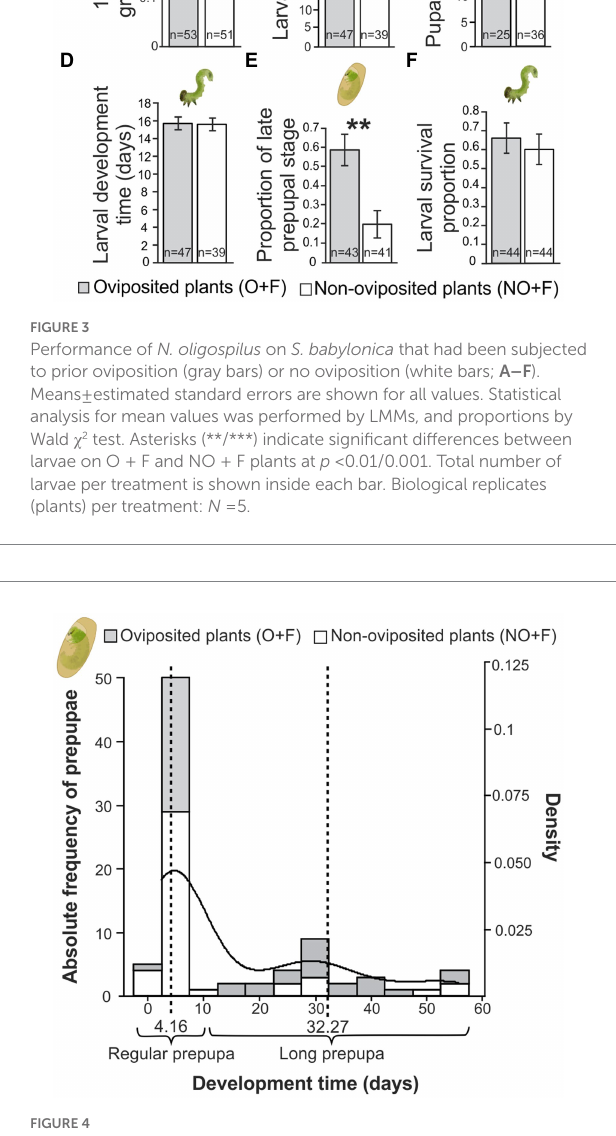
FIGURE 4 Histogram and density plot of distribution of prepupal developmental time. Absolute frequency of prepupae that developed from willows with prior oviposition (gray bars) or without oviposition (white bars) is shown in each bin of development time. Mean development time for regular and long prepupae is indicated with vertical dotted lines. The estimated probability density function (solid line) shows the bimodal frequency distribution of the